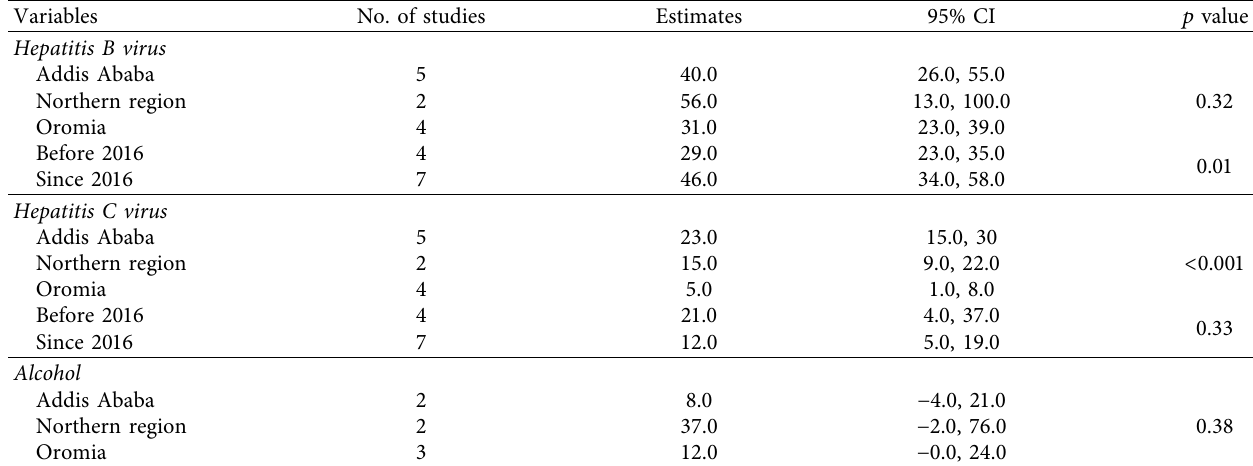
Table 6: Summary of subgroup analysis of the three most commonly reported chronic liver disease etiology estimates in terms of study regions and publication/study year in Ethiopia, 2021.